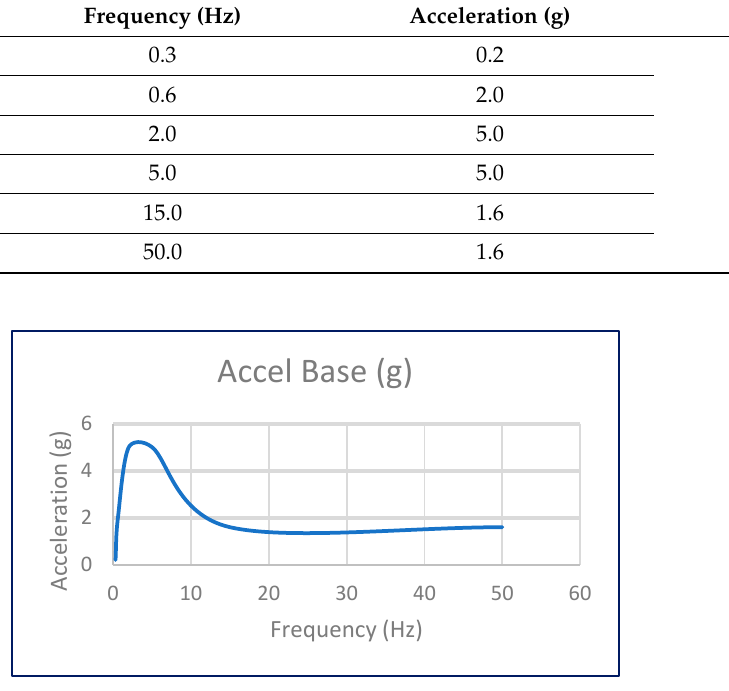
Figure 3. Acceleration base input.